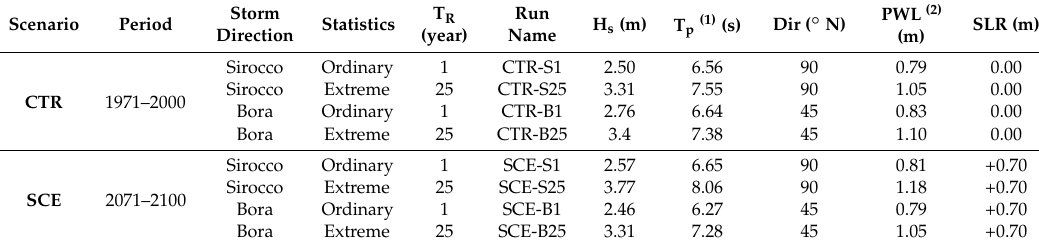
Table 2. Characteristics of the simulated scenarios, with the significant wave height H s , the peak period T p , the mean wave direction Dir, the peak water level PWL, and the sea-level rise